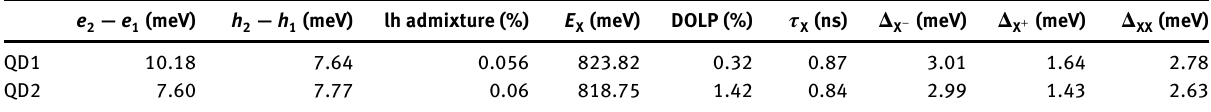
Table 1: Results of calculation for the idealized (QD1) and realistic (QD2) models of a QD: first excited level splitting for the electron and the hole, light-hole admixture, X ground state energy, DOLP, X lifetime, carrier-complex binding energies with respect to X energy.